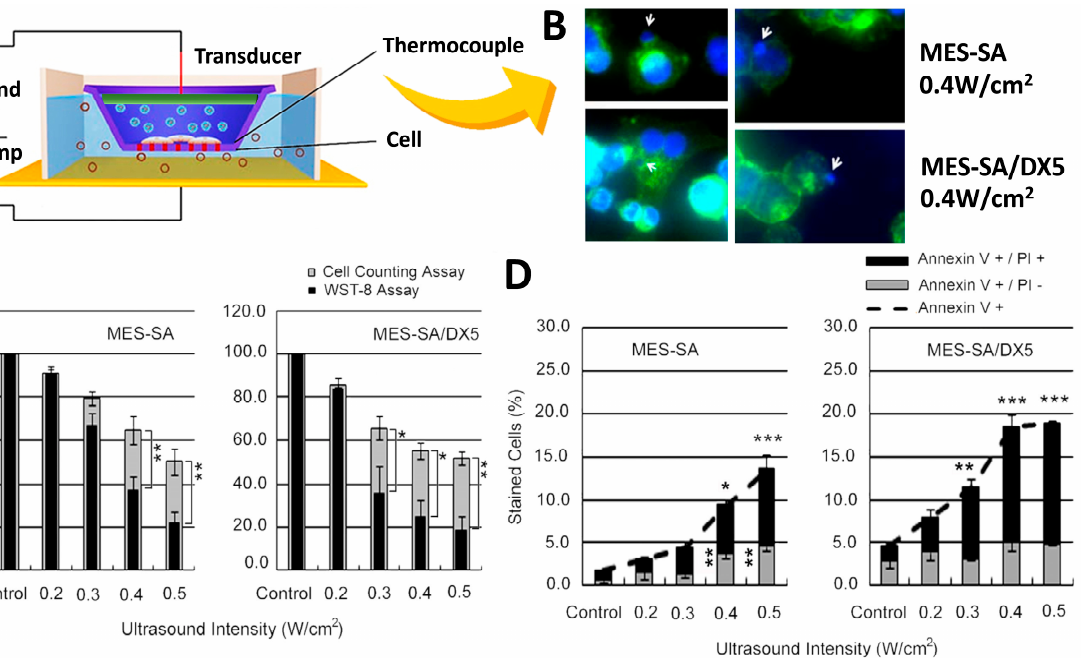
Figure 4. ( A ) Schematic of the apparatus used to expose cells to ultrasound in vitro. Cells are cul- tured in transwells, and liposomes deliver siRNA or shRNA to inhibit the drug resistance of can- cer cells. ( B ) After sonication at 0.4 W/cm 2 for 24 h, the differences and sensitivity results of drug-sensitive uterine sarcoma cell lines before and after adding lipospheres (DX5) were observed with conjugate focus microscopy. White arrows indicate nuclear budding and demonstrate the inhibition of cells after adding lipospheres. Cell viability was assessed by: ( C ) WST-8 and cell-counting assays, showing that, after adding DX5 lipospheres, the viability of the cells was significantly inhibited. ( D ) Flow cytometric analysis of FITC-labeled Annexin V showing the cytostatic conditions. Asterisks (*) indicate the statistical significance of the difference between the absolute percentages obtained from cell counting assays, * p < 0.05, ** p < 0.1, and *** p < 0.01 considered significant. Adapted with permission from Ref. [107]. Copyright 2012 PLOS.